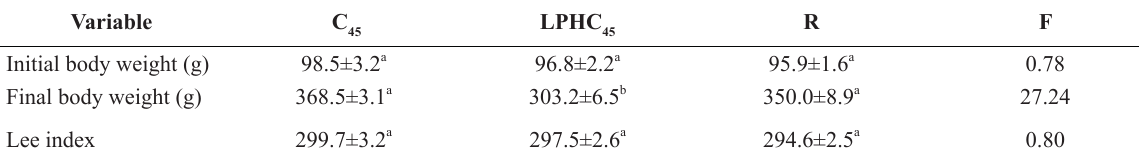
, LPHC , and R rats.* 45 45